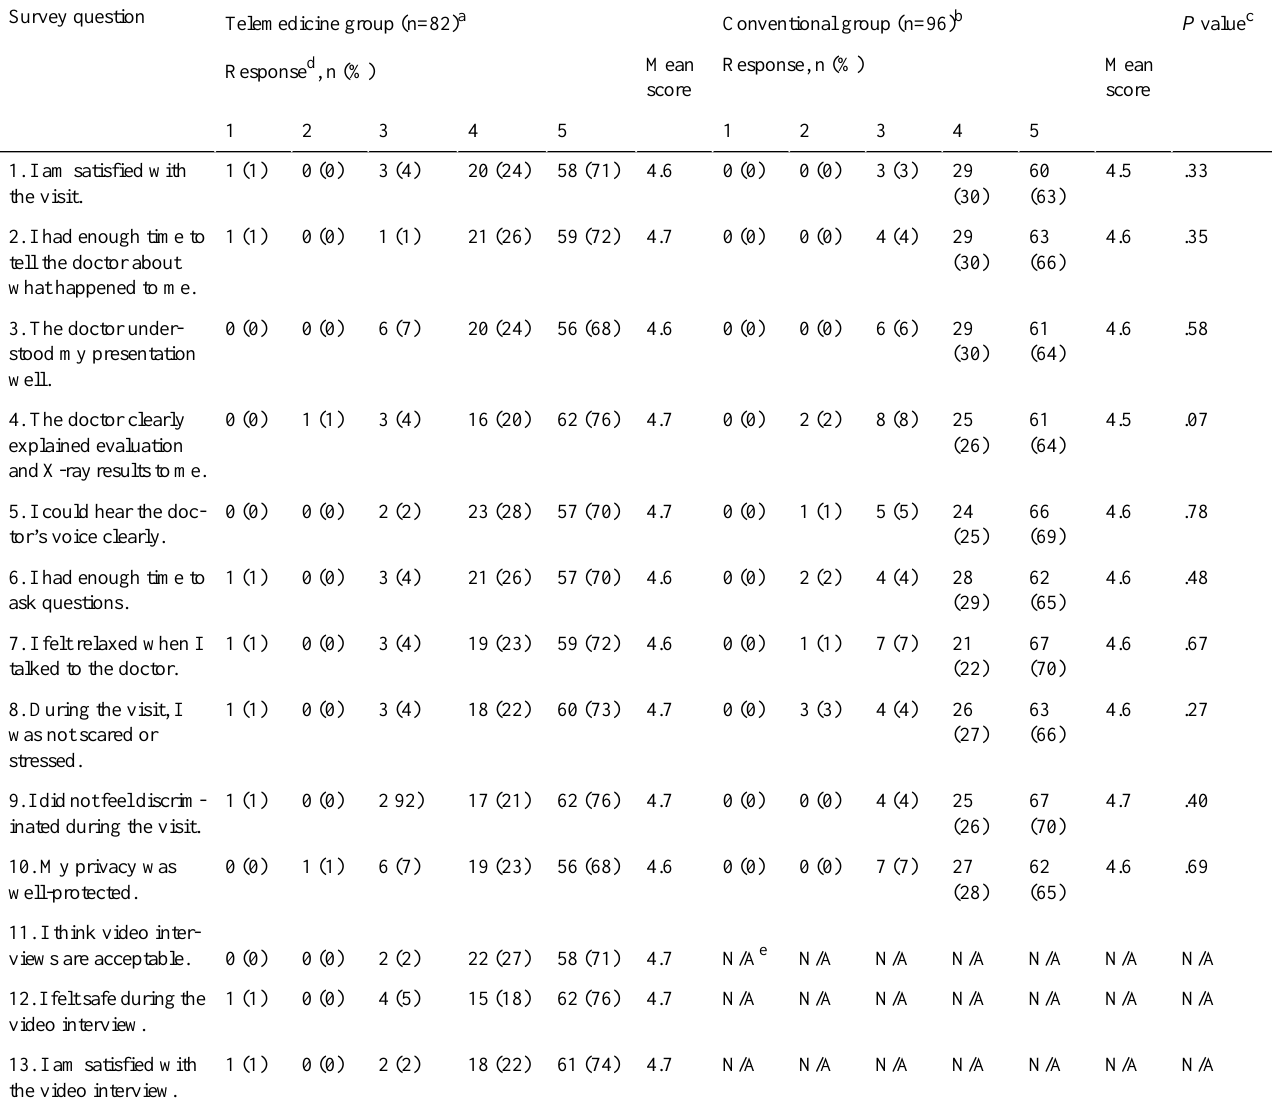
Table 3. Numbers of respondents by point of the 5-point Likert scale and mean scores of the telemedicine and conventional